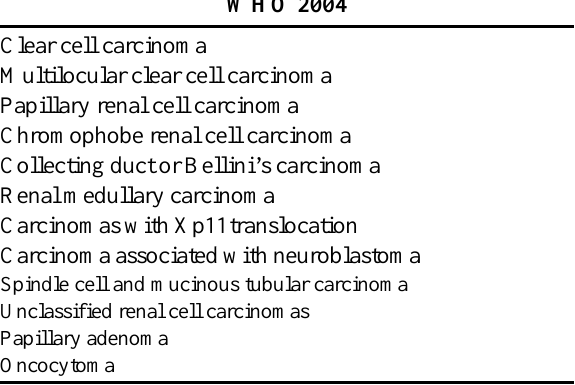
Classification of Renal Epithelial Neoplasms - WHO